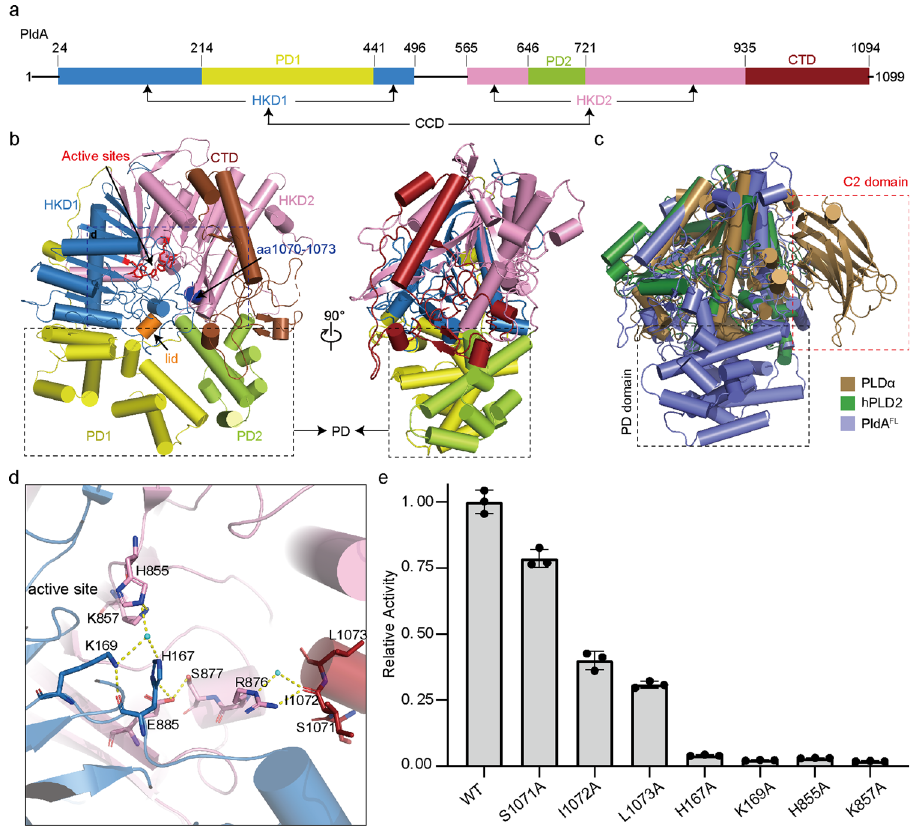
Fig. 1 | Overall structure of PldAFL. a Schematic representation of the domain structures of PldA. The PD1, PD2, HKD1, HKD2, CTD, lid, active sites, and aa 1070 – 1073 are colored in yellow, limon, sky blue, pink, fi rebrick, orange, red and blue, respectively. b Model of PldA with two views. The colors of the domains are the same as those in ( a ). c Superposition of the PldA FL (slate), hPLD2 (PDB: 6OHO, forest), and A. thaliana PLD α (PDB: 6KZ9, sand). The distinguishing features of PLD α and PldA are the C2 domain (red dotted line) and PD domain (black dotted